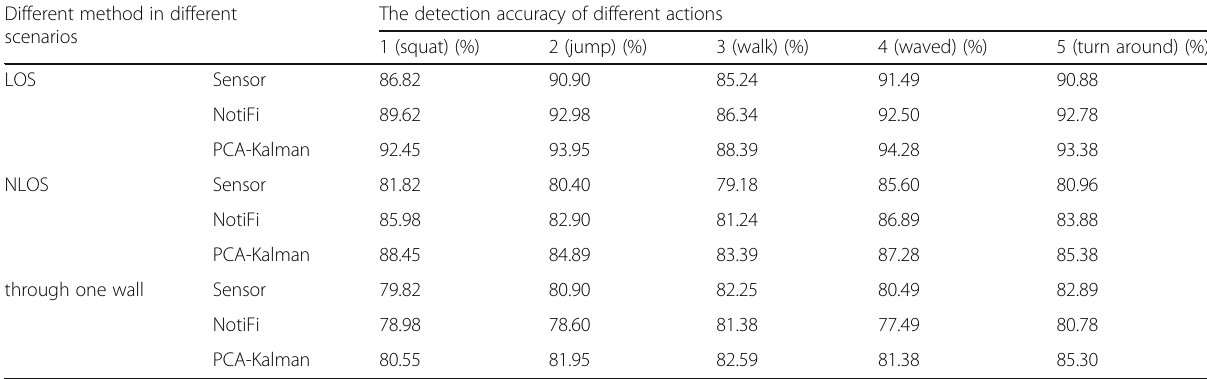
The detection accuracy of different